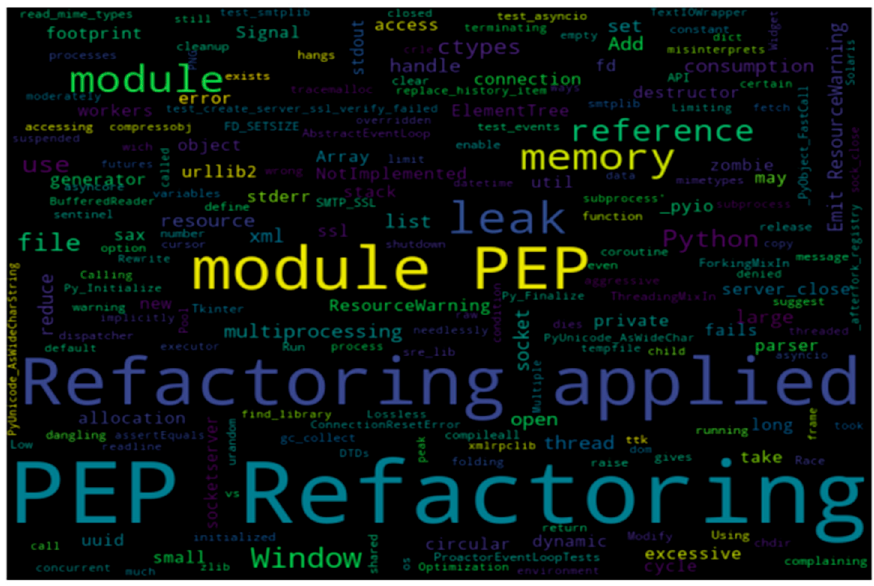
Figure 8. Word cloud of “Security” error.